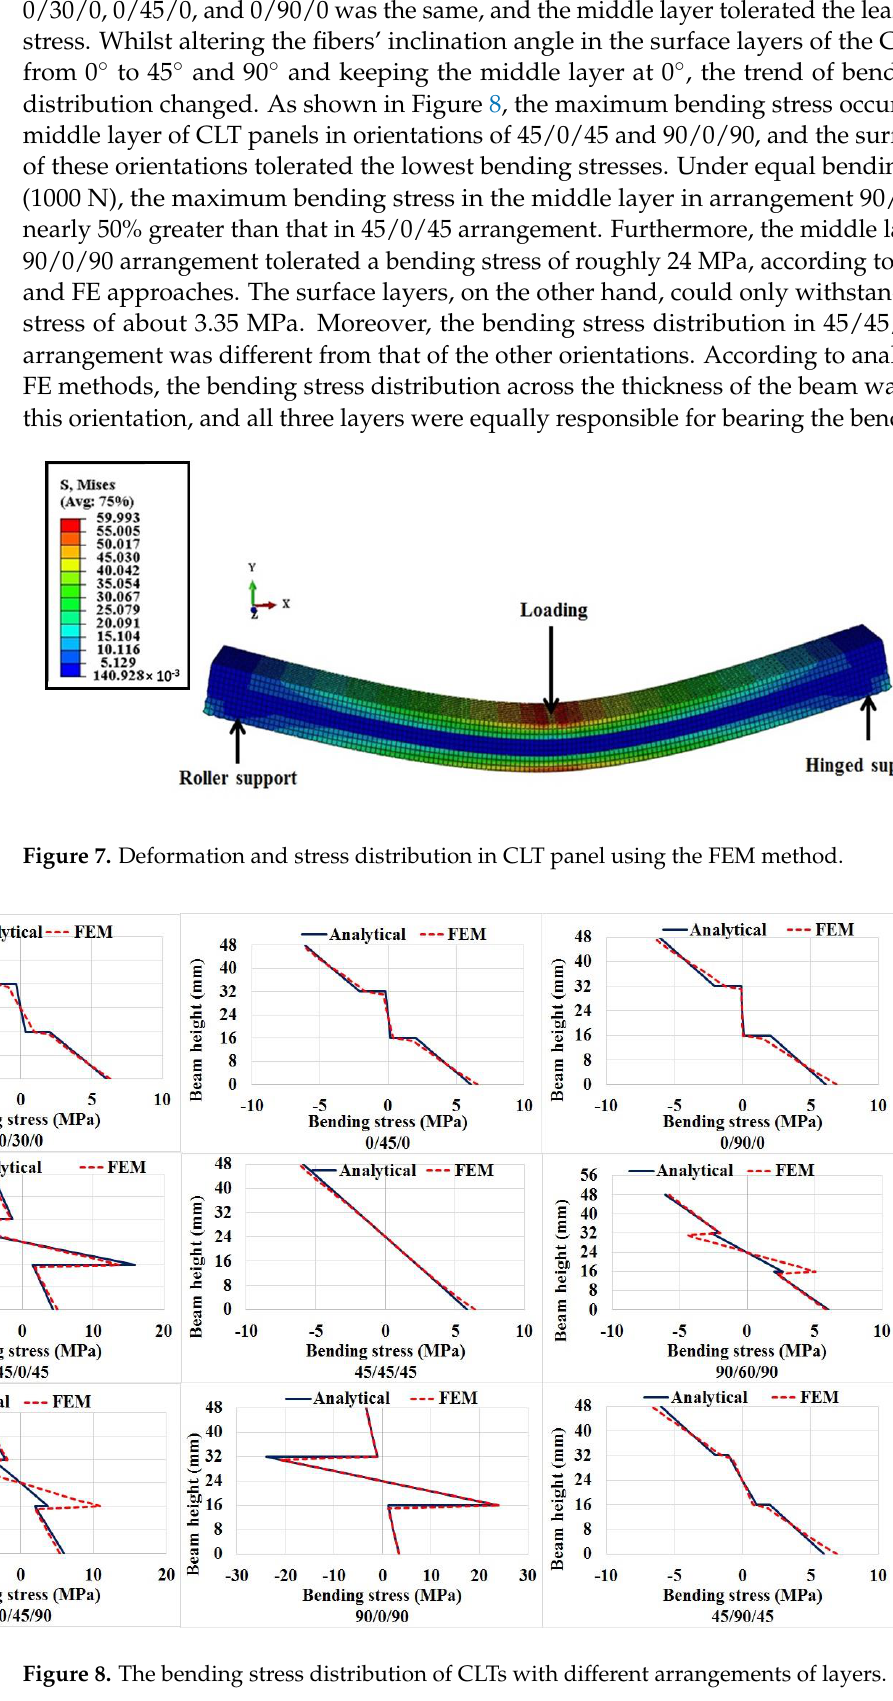
Figure 8. The bending stress distribution of CLTs with different arrangements of layers.